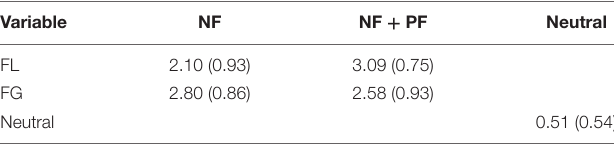
TABLE 3 | Means (and SDs) for face level and frame (Study